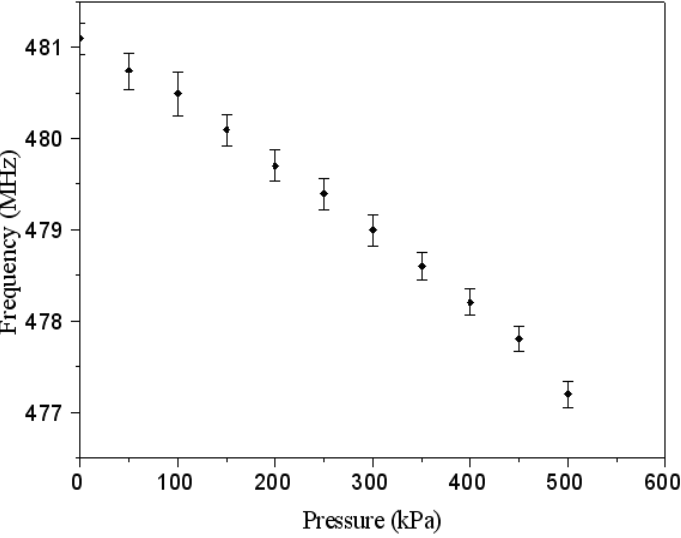
Figure 12. Measured results of output frequency in the pressure sensor with ring